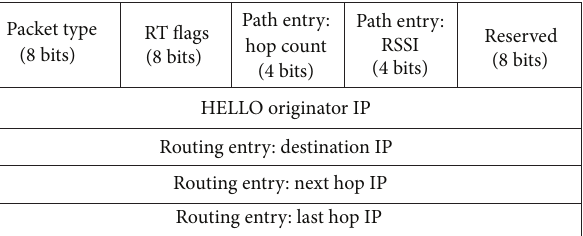
Figure 4: The keep alive packet format.